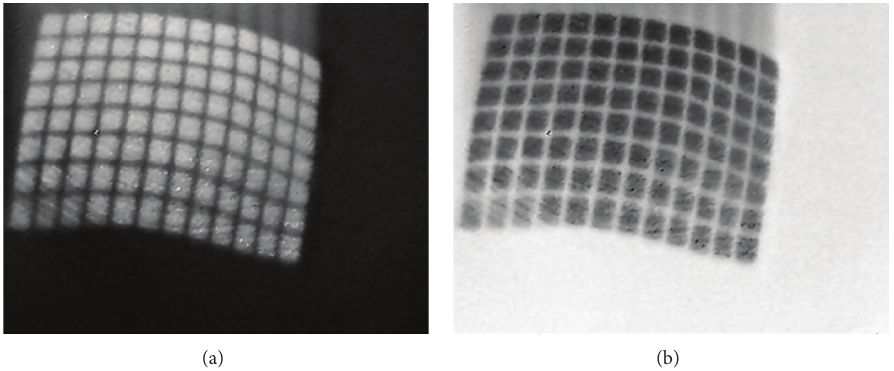
Figure 4: Left (a) grayscale image and (b) negative image.